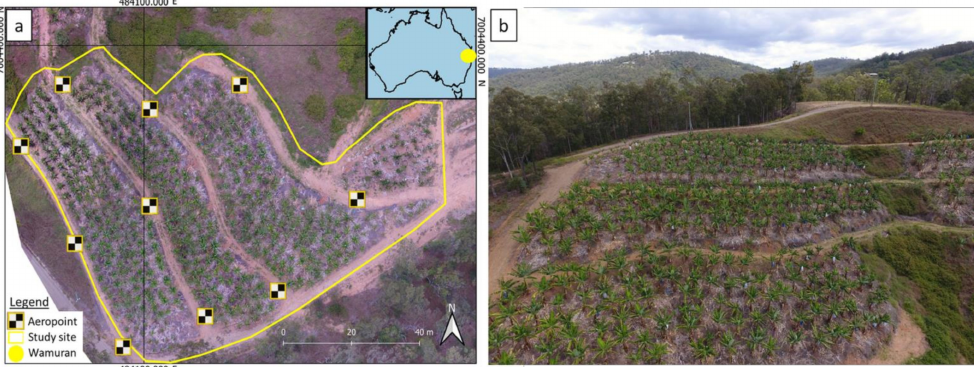
Figure 1. ( a ) Location of study site in Wamuran, Queensland, Australia, illustrating typical AeroPoint distribution, and ( b ) aerial view of the upper portion of the study site taken from the north eastern corner of the site facing south